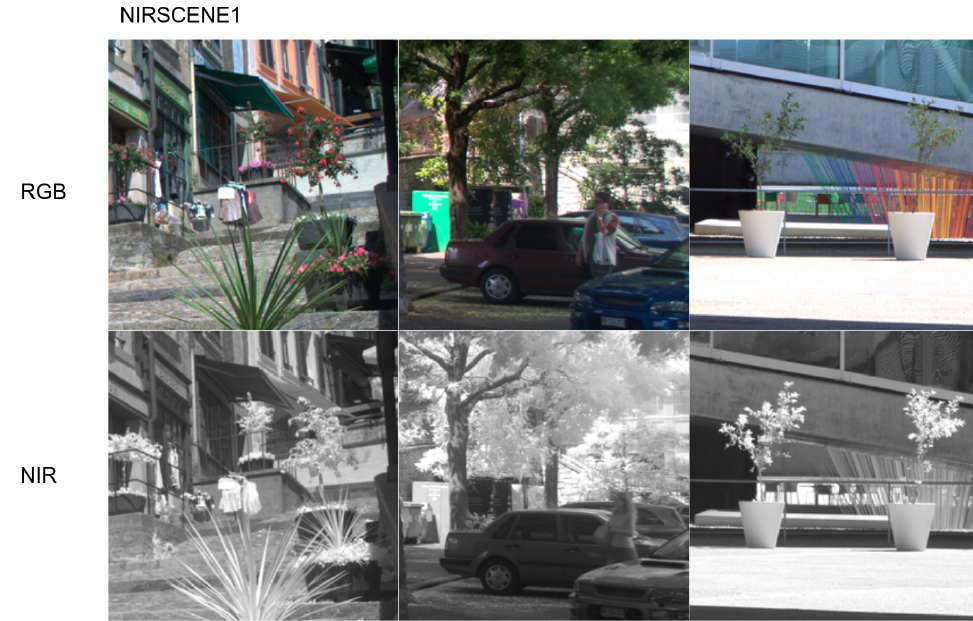
Figure 4. RGB ( top row ) and NIR ( bottom row ) samples drawn from our nirscene1 dataset (256 × 256). This dataset was mostly taken in outdoor environments with band-cutoff filter equipped two digital single-lens reflex (DSLR) cameras. Note that there also exists noticeable temporal gap between NIR and RGB images ( middle column ).